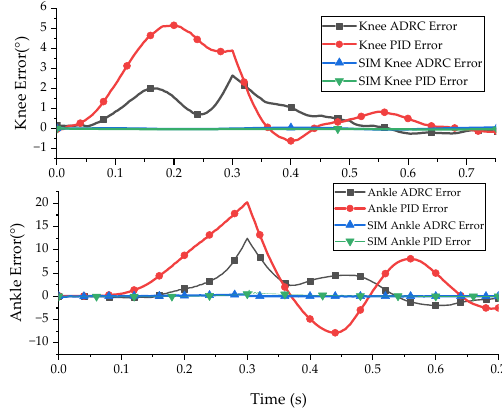
Figure 11. Experimental error of bionic leg joint angle control.